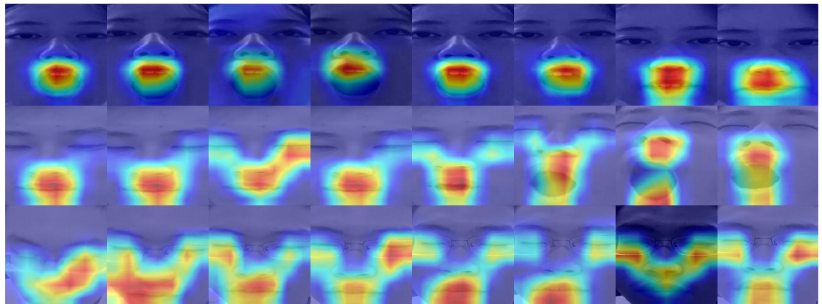
Figure 6. The class activation heatmap of our backbone model on samples of eye anomalies, mouth anomalies, and eye-head anomalies. The contribution of each region is represented by blue to red from low to